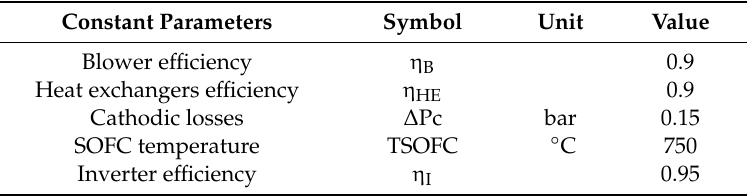
Table 5. Constant parameters in the